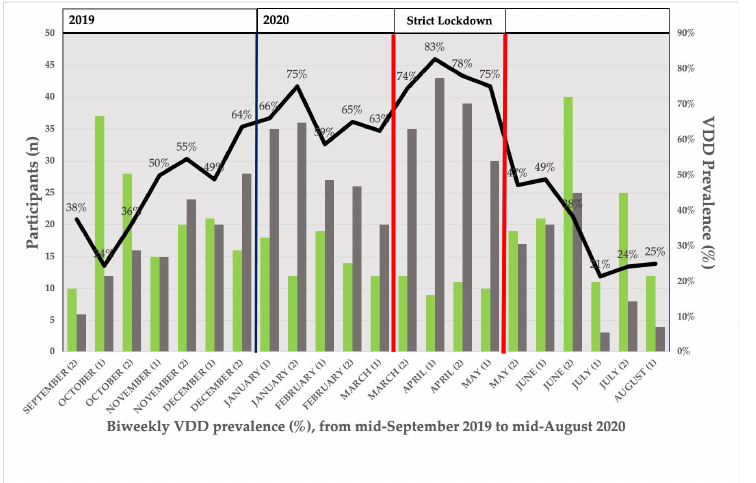
Figure 3. Distribution of VDD prevalence by fortnight from mid-September 2019 to mid-August 2020, expressed as percentage of participants with VDD by biweekly intervals (solid black line). Bars represent participants with 25(OH)D >20 ng/mL (green bar) or <20 ng/mL (grey bar) in each biweekly period. Dark blue vertical line represents the beginning of year 2020. Red bold vertical lines represent the beginning and the end of strict lockdown.